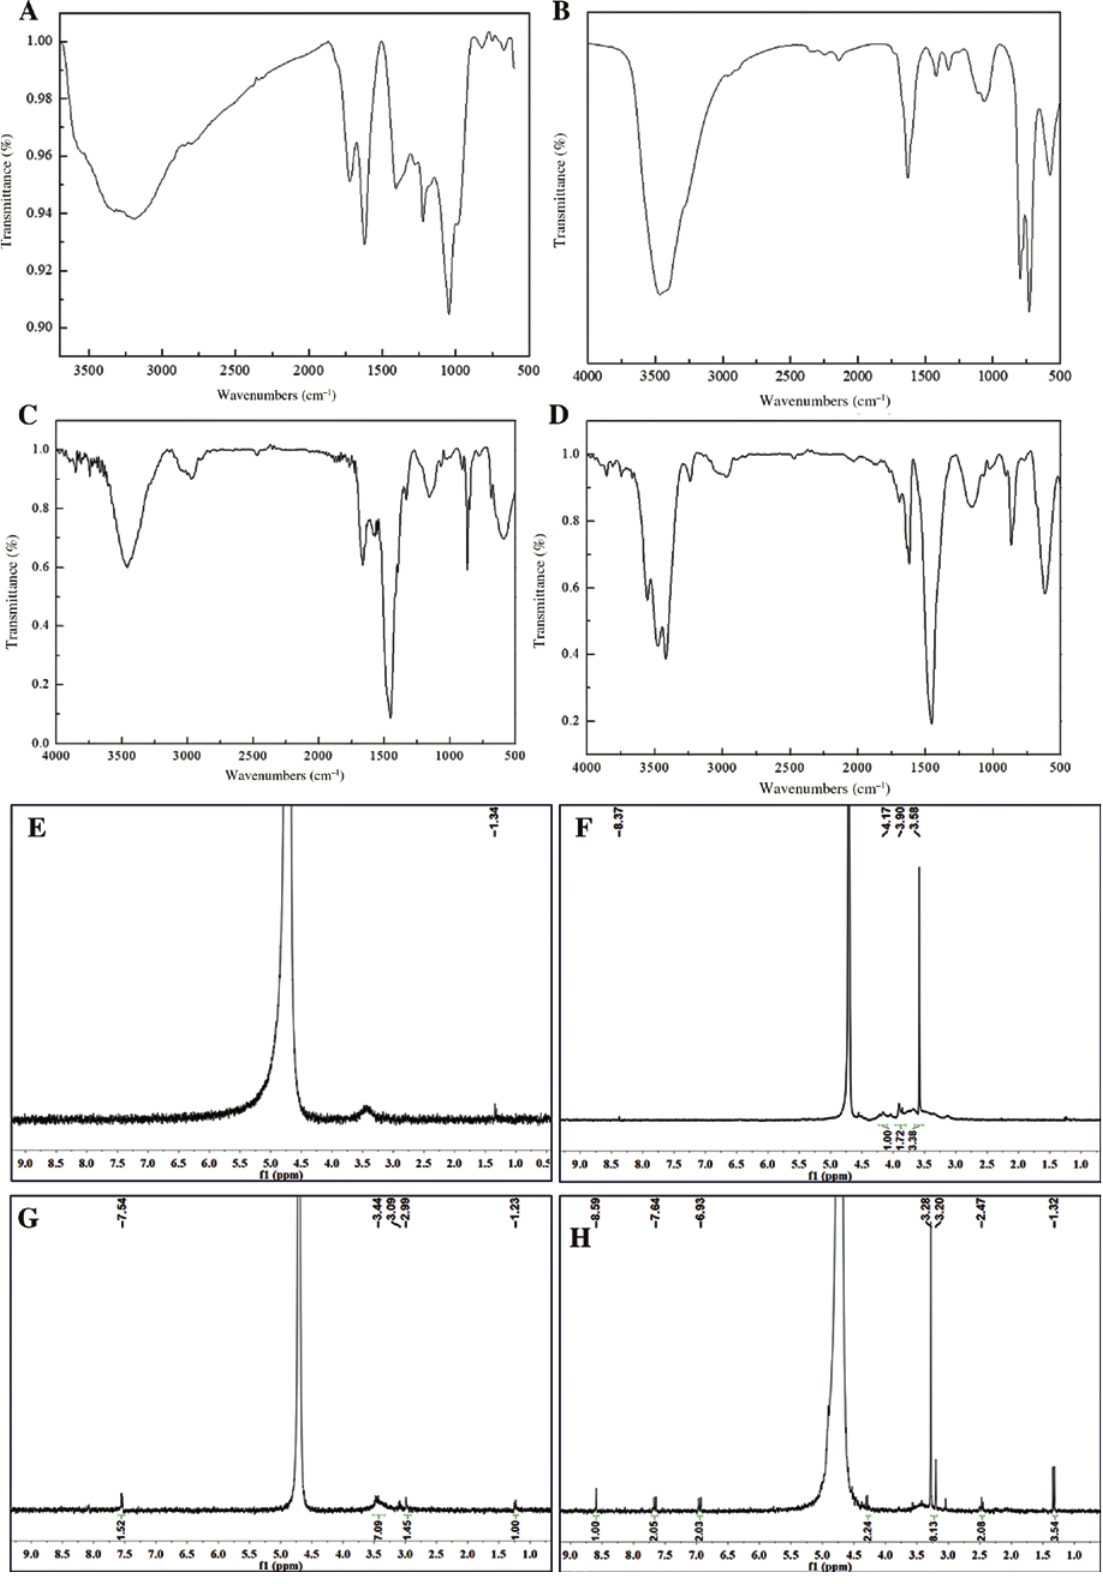
Figure 1: FTIR spectral image of GO (A), CMC (B), CMC-GO (C) and MTX/CMC-GO (D); 1 H NMR spectra of GO (E), CMC (F), CMC-GO (G) and MTX/ CMC-GO